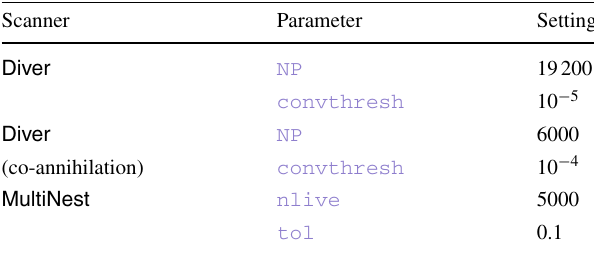
Table 3 Samplers and their settings for the different scans of this paper Scanner